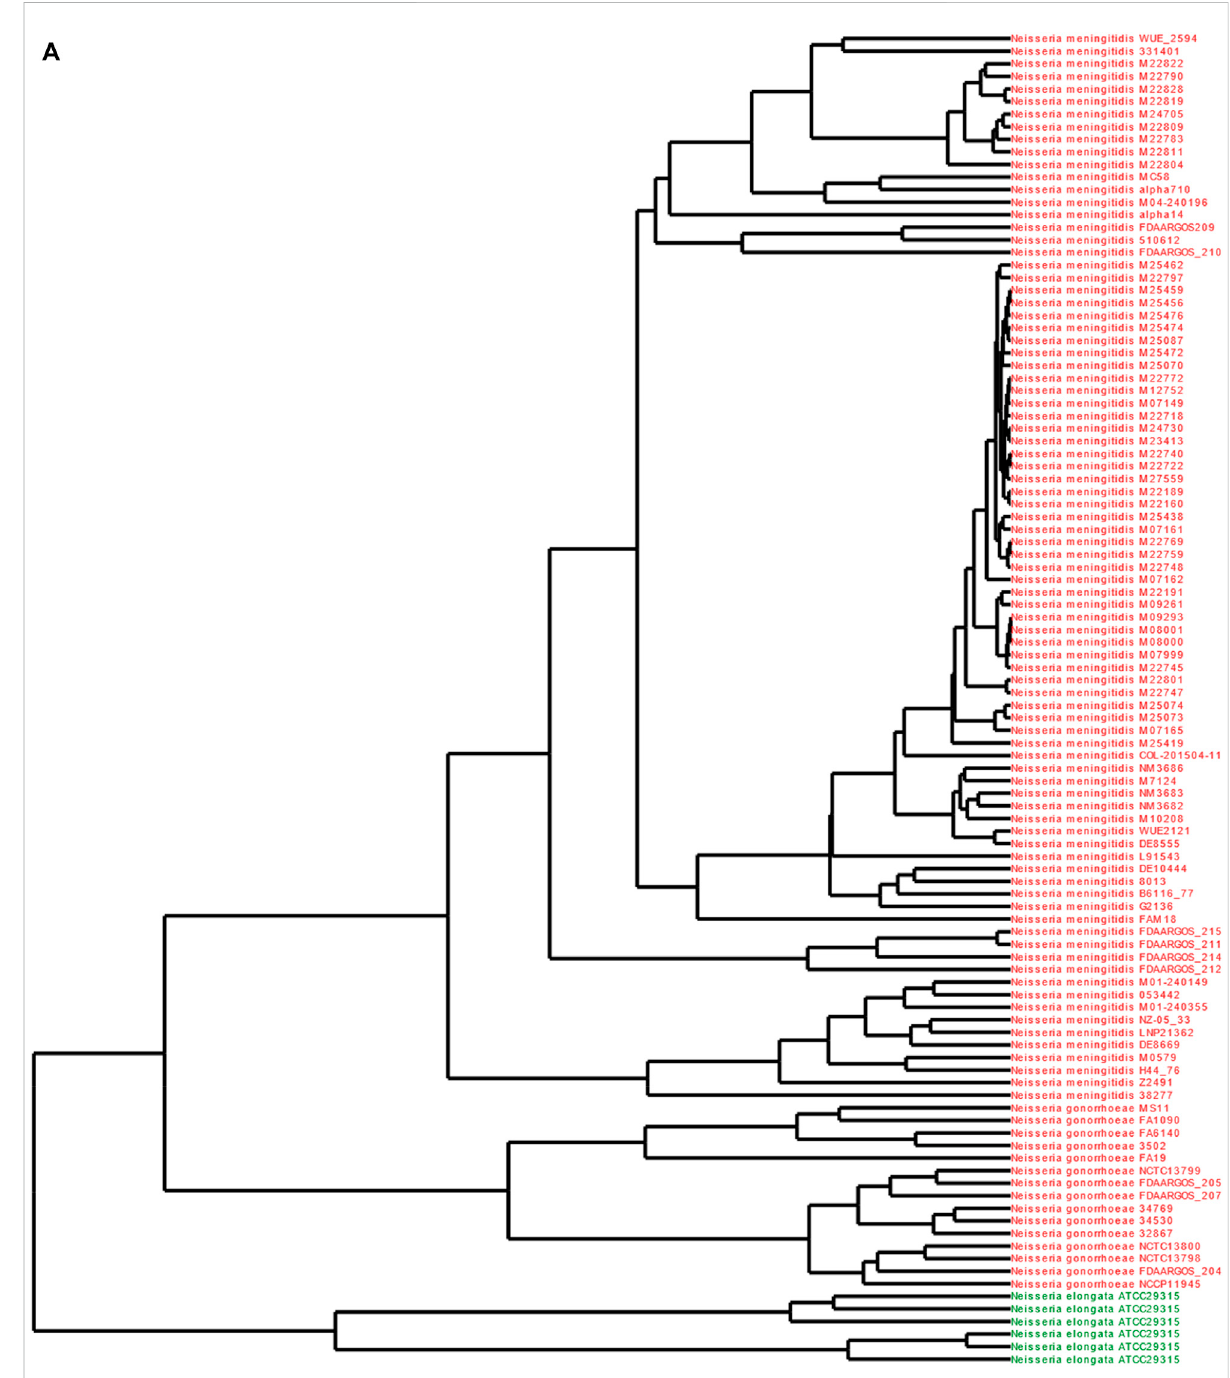
FIGURE 4 Hazardous functions separatepathogens fromnon-pathogens. Shownarethedendrogramsfor Neisseria (A) ,Burkholderia (B) ,Clostridium (C) , Streptococcus (D) , Bacillus (E) , Pseudomonas (F) , E. coli (G) , and Mycobacterium (H) , with pathogenic species colored in red and non-pathogens colored in green. An additional plot for E. coli , strati fi ed by the groups shown in Figure 3 is shown in Supplementary Figure